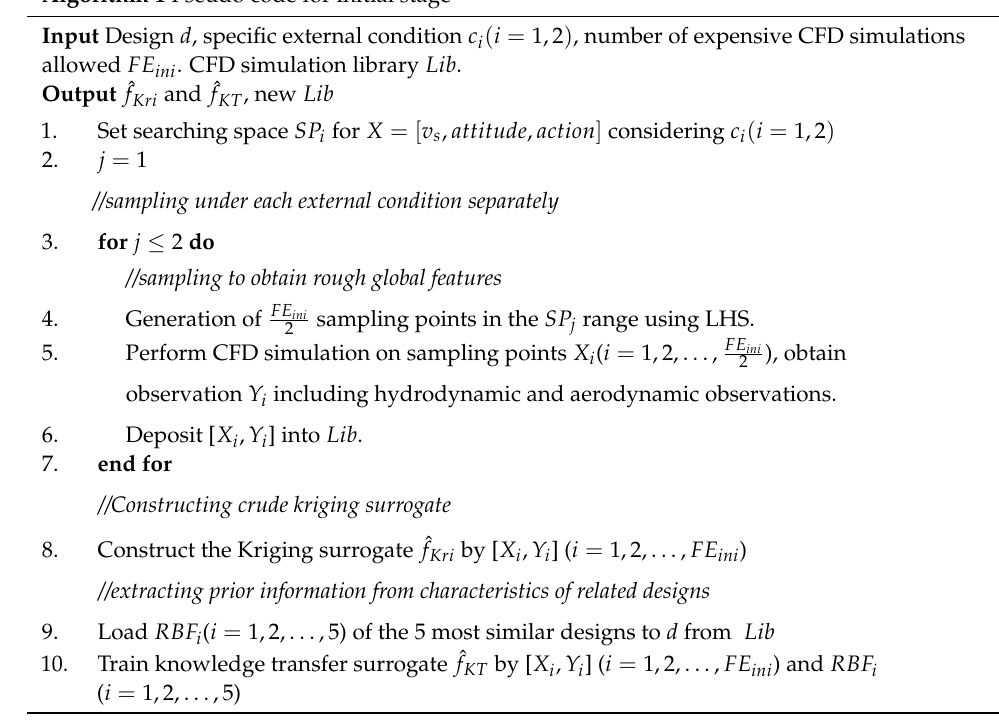
Algorithm 1 Pseudo code for initial